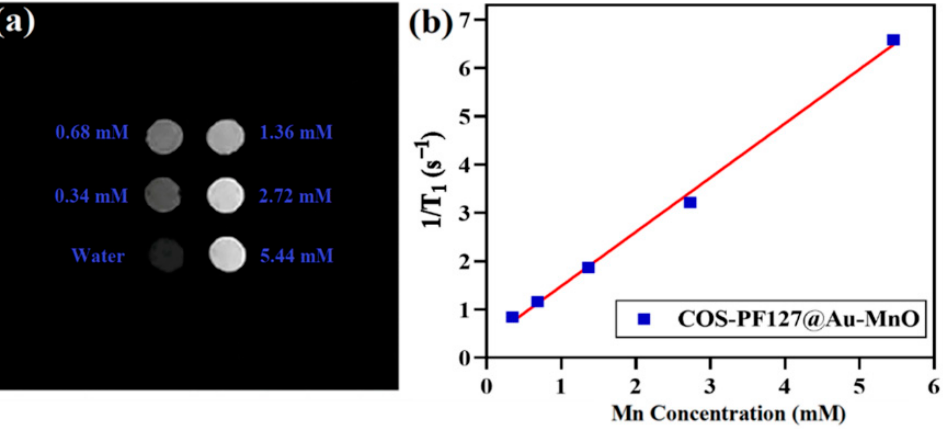
Figure 3. ( a ) T 1 -weighted MR images at room temperature and 0.55 T, and ( b ) longitudinal relaxation rate obtained using COS-PF127@Au-MnO HNPs aqueous suspensions as a function of Mn concentrations.